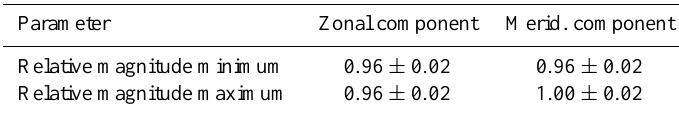
Table 4. Mean and standard deviation of daily relative magnitude minima and maxima for “large-FCA” and “O-mode large-FCA” from 1 January 2001 to 25 July